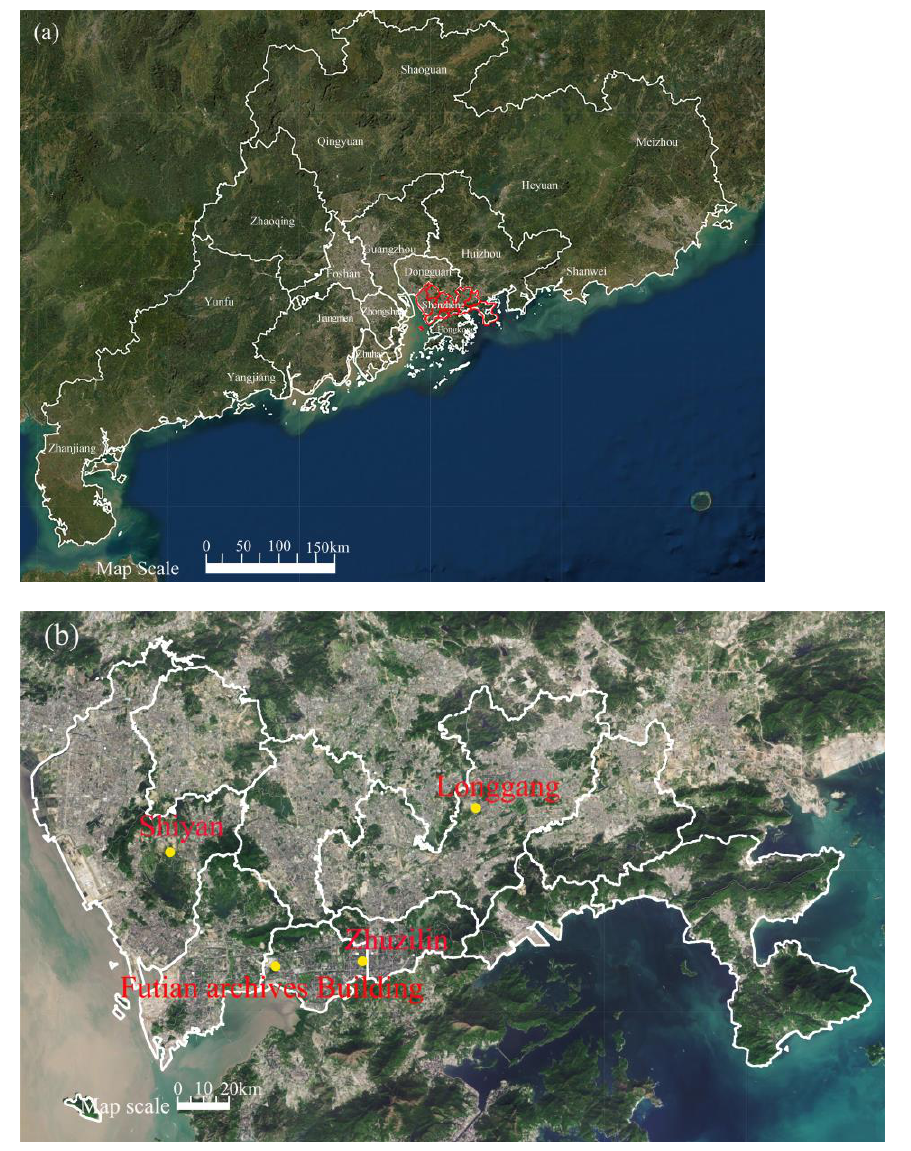
Figure 1. The geographical location of the Pearl River Delta region in China ( a ) and the research station in Shenzhen ( b ) (marked as yellow dot).